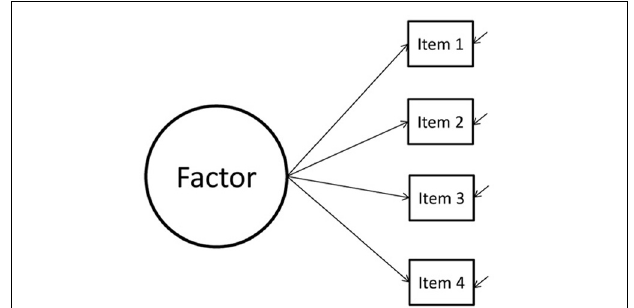
FIGURE 1 | A hypothetical model.